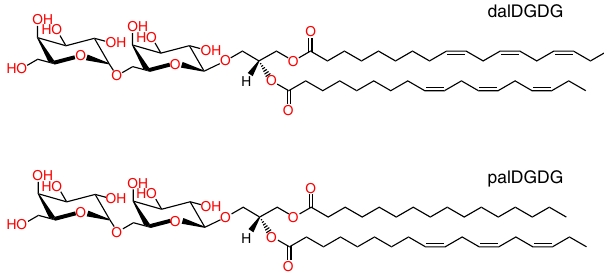
Figure 6 | Dominant species of DGDG. Chemical structures of dalDGDG (top) and palDGDG (bottom) lipids, differing in the saturation of the hydrocarbon